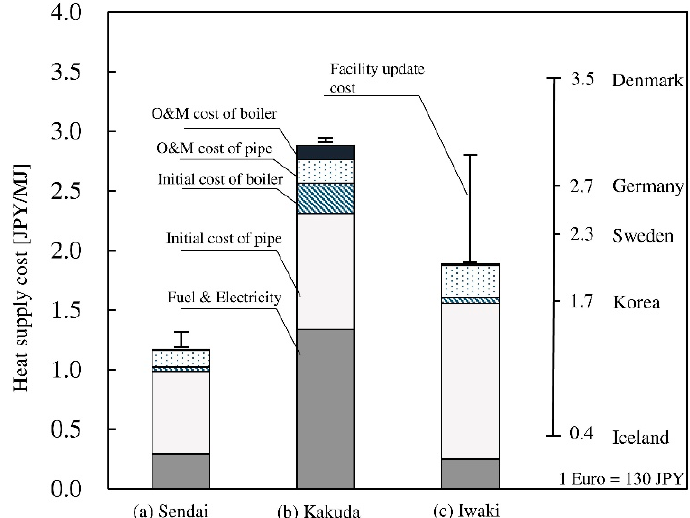
Figure 10. Cost breakdown of DHSs for three cities.